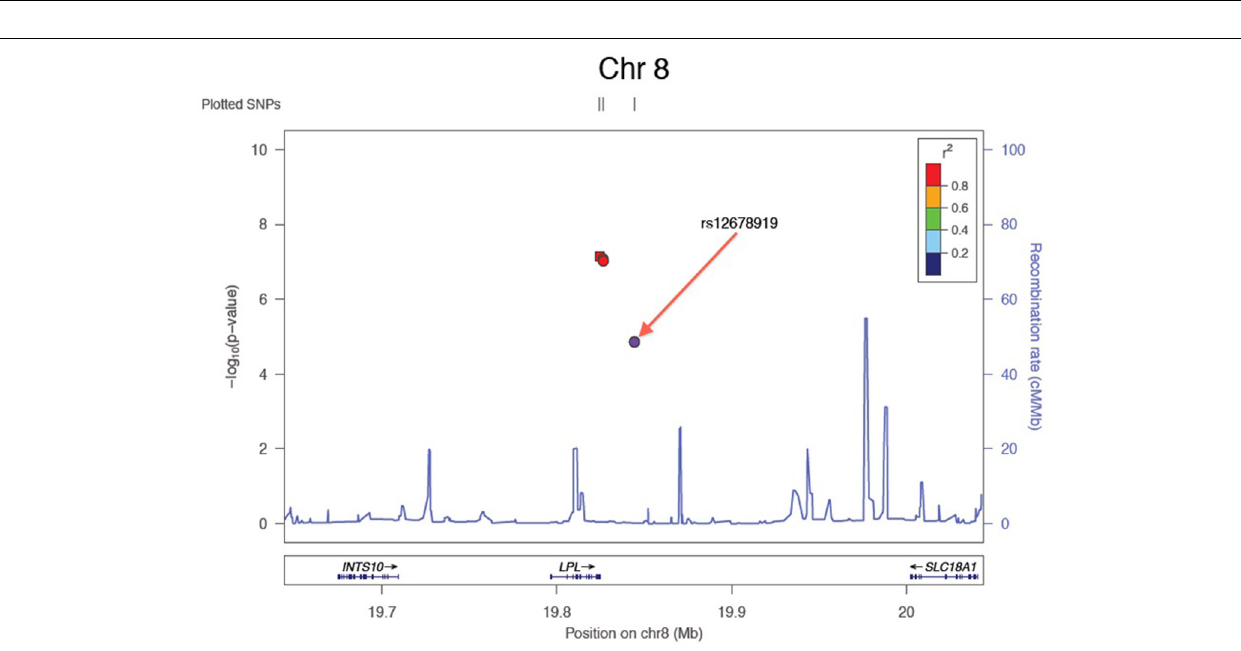
FIGURE 3 | Zoom plot showing association of SNPs in LPL region (Chromosome 8) associated with HDL-C, and linkage disequilibrium between associated SNPs and index SNP.